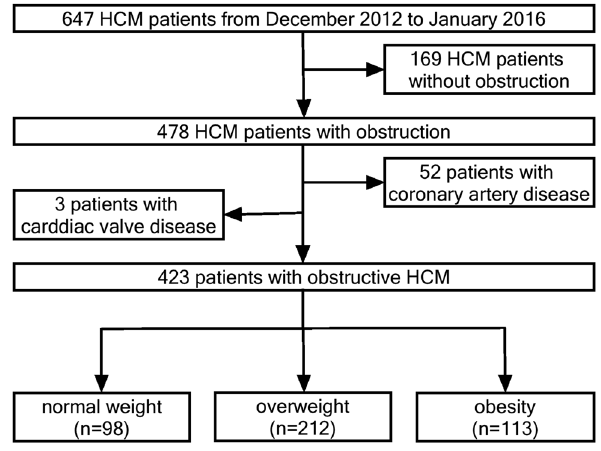
Figure 1: Flowchart of patient inclusion in this study. HCM, hyper - trophic